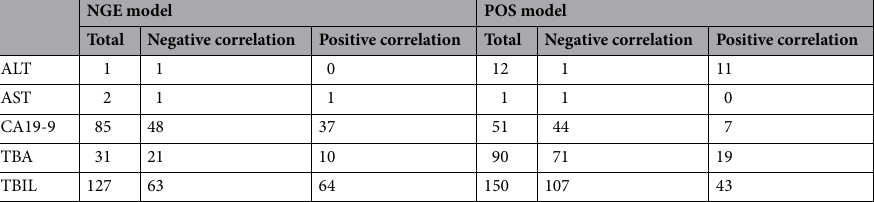
Table 1. Correlation analysis between clinical blood indicators and the number of metabolites (Spearman Analysis, |r| ≥ 0.7). In POS and NEG models, clinical blood indicators are correlated with multiple metabolites, suggesting the potential importance of indicators in the disease